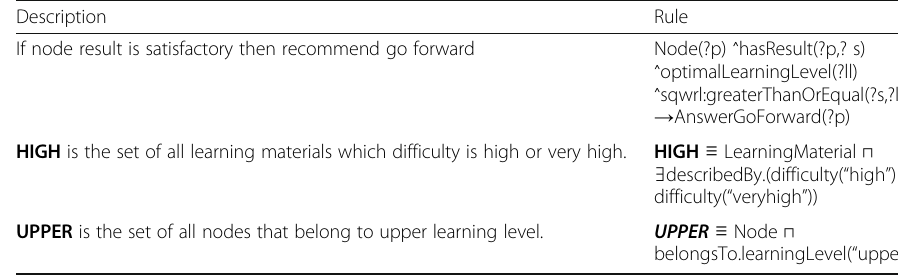
Table 2 Derivation rules and set definition Description